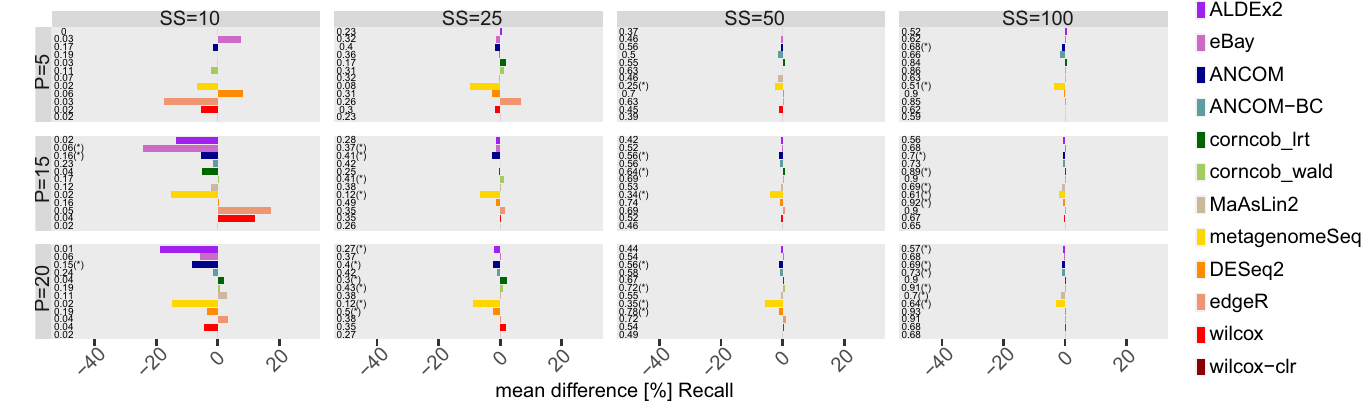
PLOS Computational Biology | https://doi.org/10.1371/journal.pcbi.1010467 September 8,